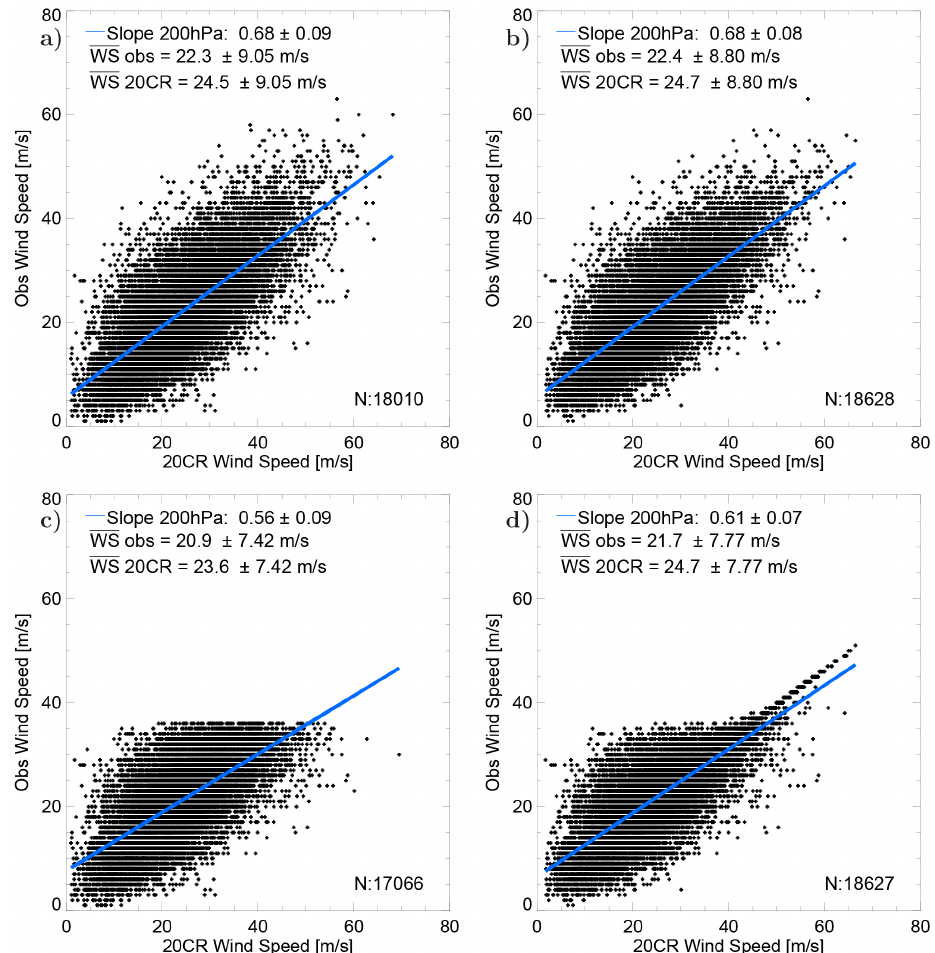
Figure 4. Scatterplots of observed wind speed vs. NOAA-20CR at station 72764 at 200hPa with different treatment of high wind speeds during the period 1960–2010. (a) original observed wind speed; (b) observed wind speed, missing values replaced by scaled NOAA-20CR wind speeds; (c) observed wind speed, all values above 60% of the maximum observed wind speed set to “missing”; (d) as (c) , but values set to missing in (c) are replaced with scaled NOAA-20CR wind speeds. Mean wind speeds as well as the linear relationship between observed and NOAA-20CR wind speeds are given in inset